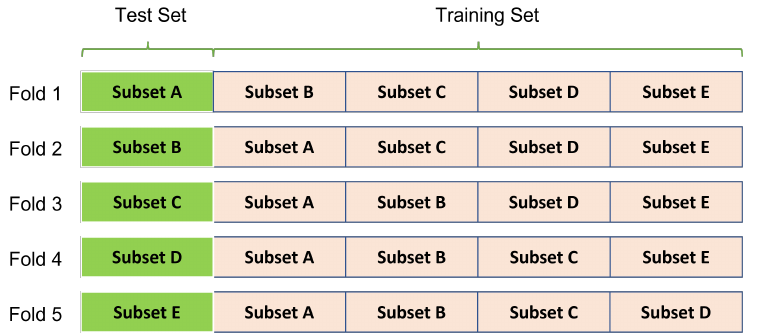
Figure 9. Diagram of K-fold cross-validation with K=5. We split the whole dataset into 5 non- overlapping subsets. For the i -th fold, the i -th subset is used as test set and the remaining subsets as training